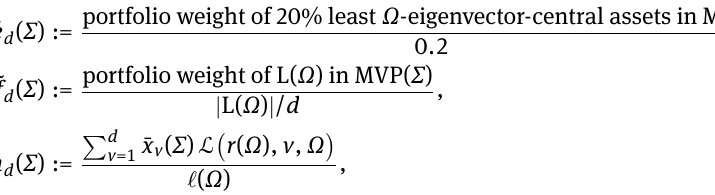
Table 3: In all major credit indices we detect a systematic overweighting of leaves resp. non-central assets in the MVP. The number of constituents of these indices (after deleting series with missing data) is given in the rightmost column.